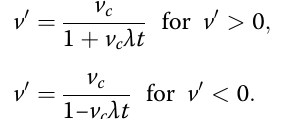
The profile of v ′ = v c − v is shown in Fig. 6. It is under- standable that ∣ v c − v ∣ will shrink to zero with an order of t − 1 . We estimate λ = 1/40 – 1/120 m − 1 from representa- tive values of C D ~ 1 with C M ~ 2 (Dean and Dalrymple 1985), and B = 10 – 30 m (Table 1), and consider the